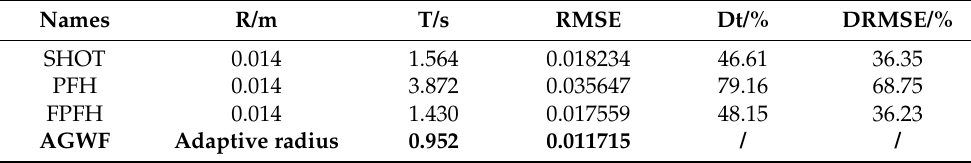
Table 4. Comparison of experimental results of different descriptors (R = 0.014 m).